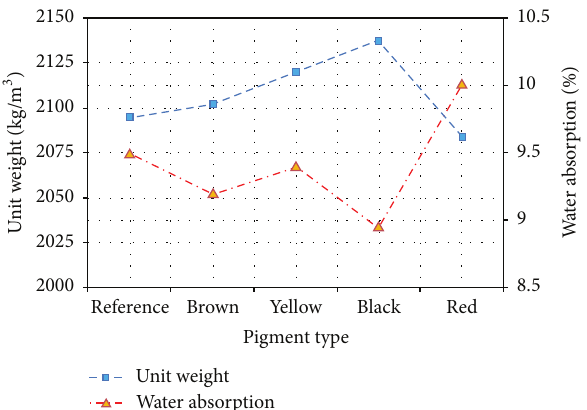
Figure 3: The impact of pigment type on the water absorption and unit